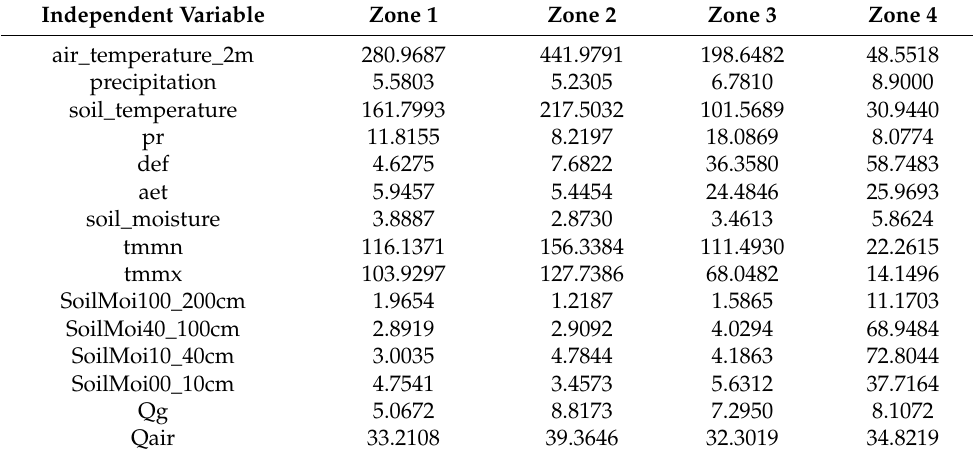
Table 8. Multicollinearity